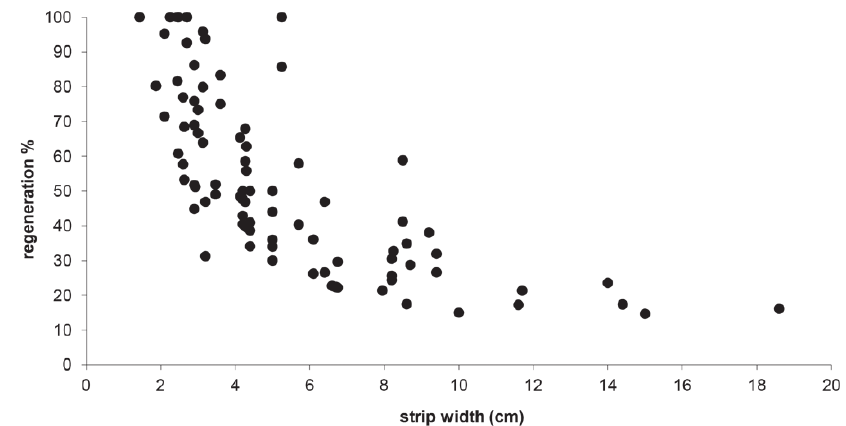
Figure 4 - Percentage of bark recovery in Drimys brasiliensis from different exploited strip width after one year following